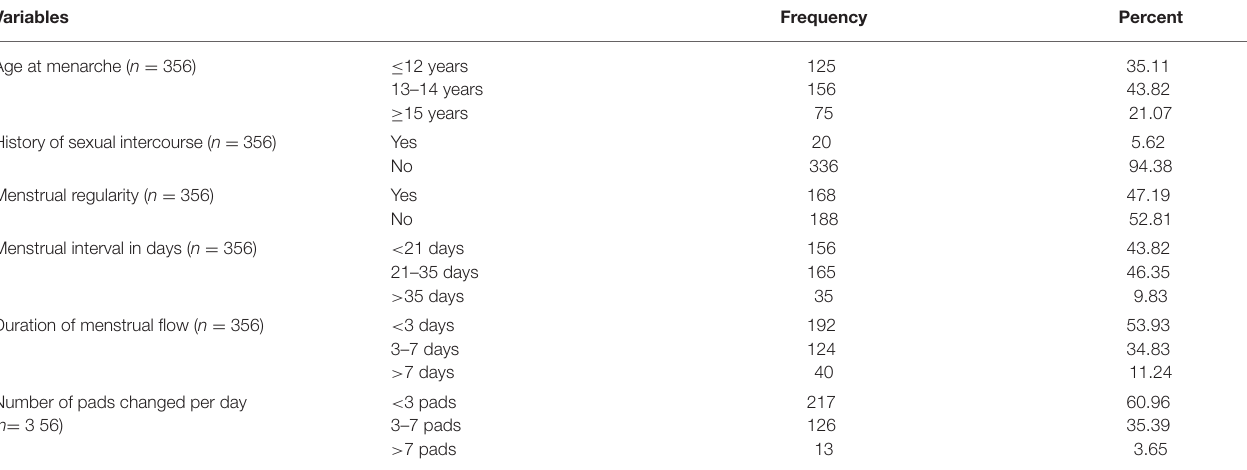
TABLE 2 | Reproductive characteristics and menstrual pattern of female undergraduate students, at Haramaya University, Ethiopia, 2020. Variables